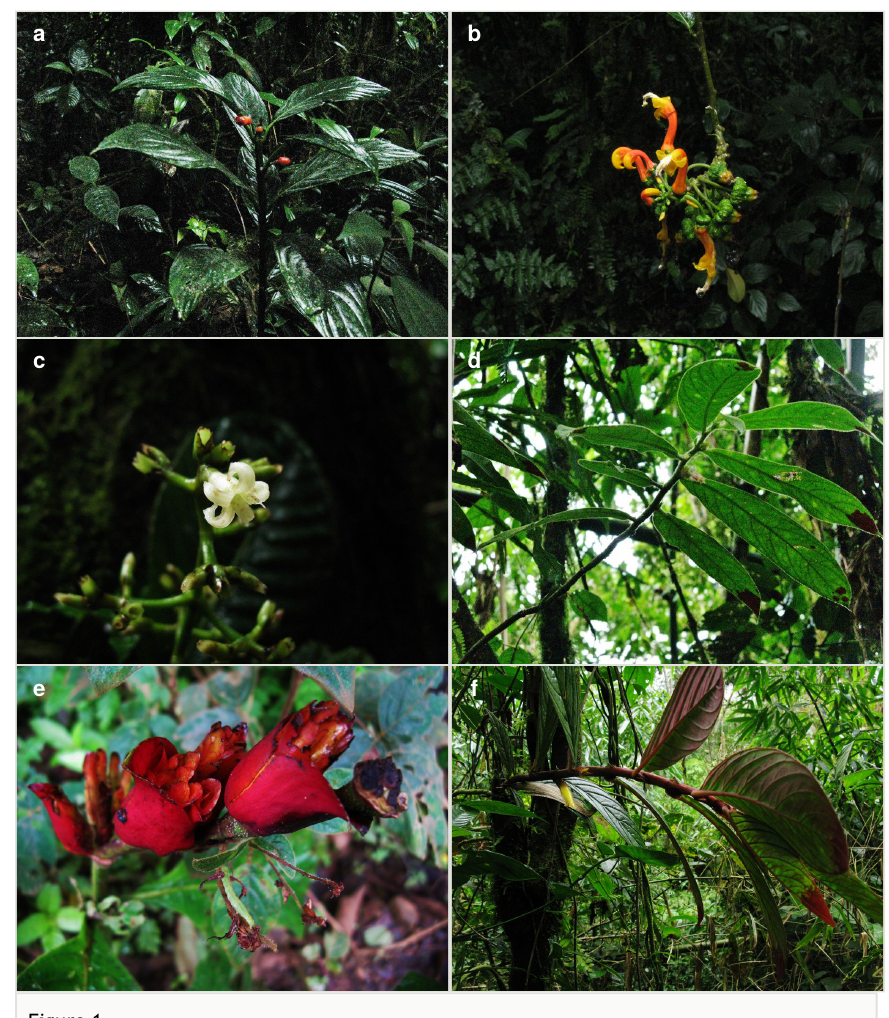
Diversity of putatively bird pollinated plants of the Manú Gradient. MMAB collection numbers listed in Table